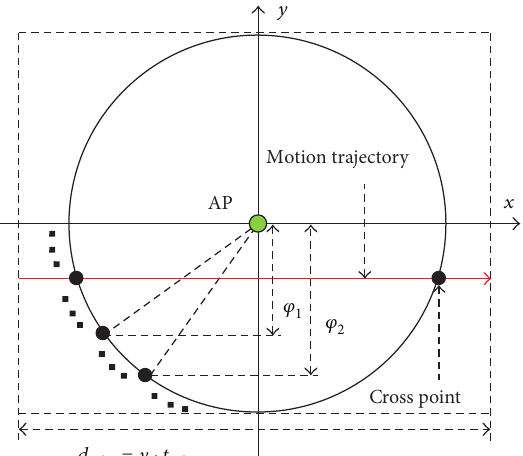
Figure 3: Schematic diagram of terminal moving through WLAN coverage.